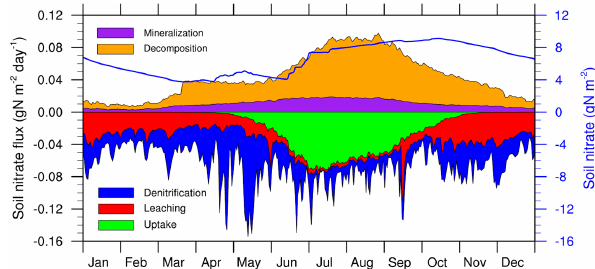
Figure 10. Daily climatology of the soil nitrate (blue solid line) and some major fluxes (color label bars) going in (humus mineralization and residue decomposition) and out (plant uptake, nitrate leaching, and denitrification) of the soil nitrate